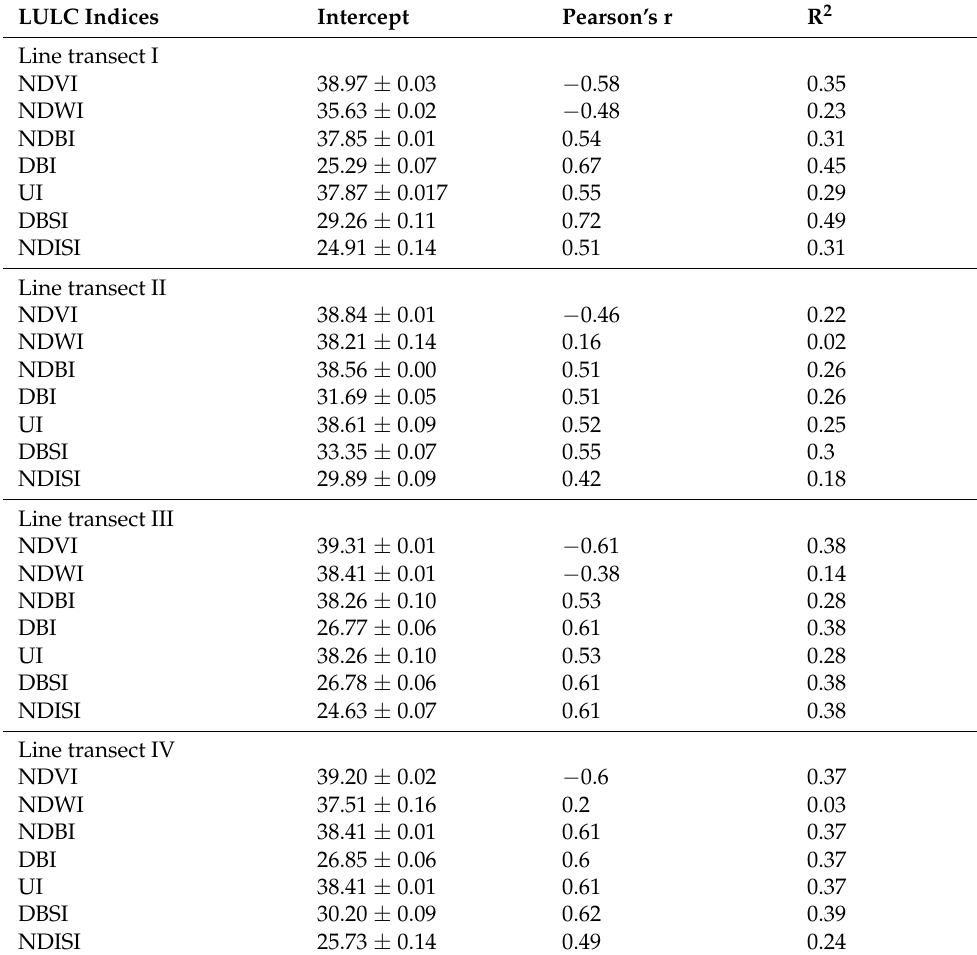
Table 5. Parsons’s correlation (r), simple linear regression (R 2 ), and multiple linear regression (MLR) between LST and LULC